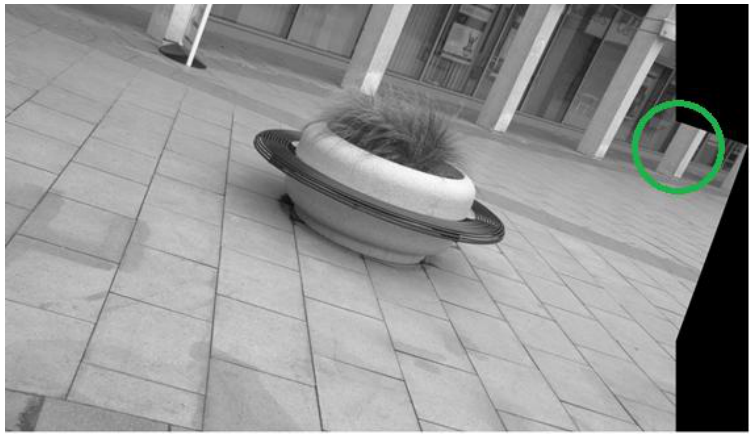
Figure 22. Image registration result for the image pair 4 of the database using the proposed framework; the region inside the green circle shows good registration.